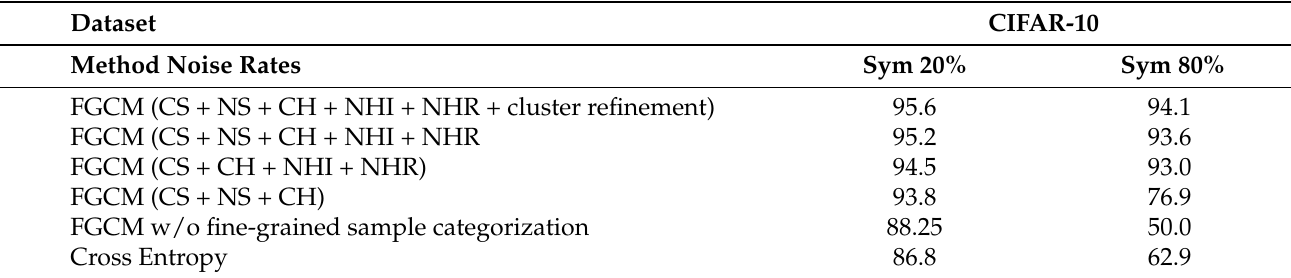
Table 6. Ablation Study results on CIFAR-10 with two different noise rates.